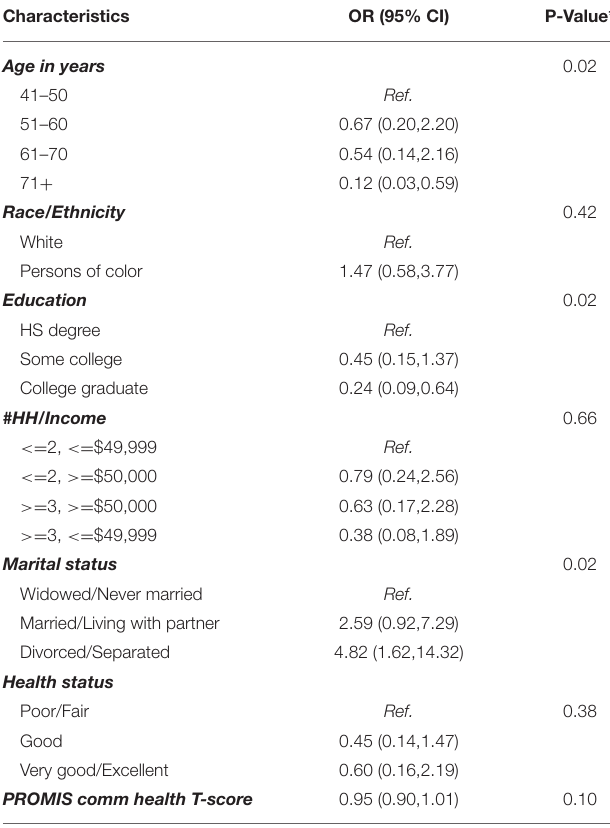
TABLE 2 | Odds Ratios (OR) and 95% Confidence Interval (CI) obtained from logistic regressions to evaluate the association of characteristics with unmet dental needs ( n =